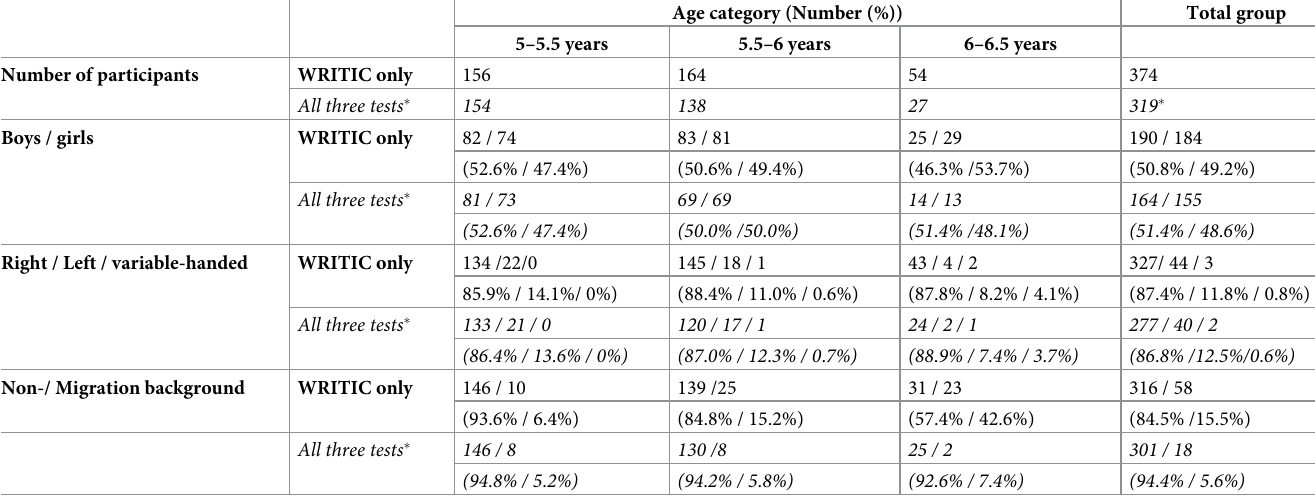
Table 1. Descriptive data of participants tested by the WRITIC only (n = 55) and by all three tests (WRITIC, 9-HPT and Timed-TIHM (n = 319). Temperature and wildlife count in the three areas covered by the study.